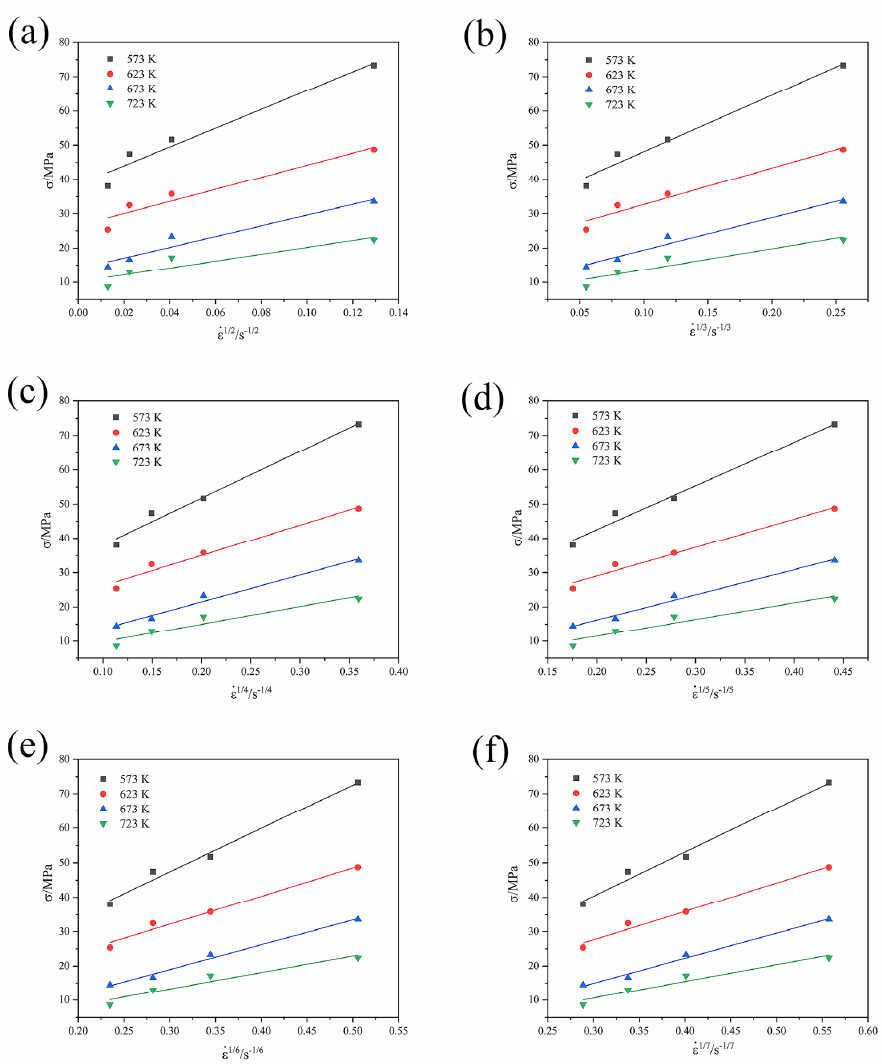
Figure 13. Linear fitting of σ against ε 1/ n for the GAZ211 alloy: ( a ) n = 2; ( b ) n = 3; ( c ) n = 4; ( d ) n = 5; ( e ) n = 6; ( f ) n = 7. (2) Deformation activation energy Q